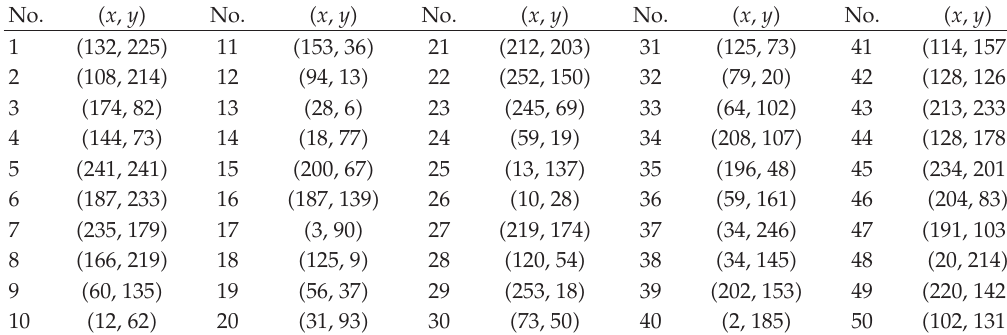
Table 1: Coordinates of the points in P.